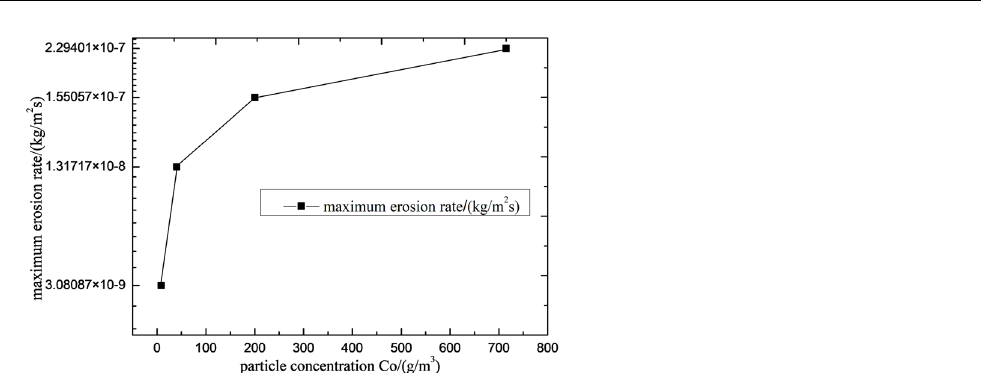
Figure 12. Distribution of erosion position and erosion degree of airfoil shape under different con ‐ centrations of particles.